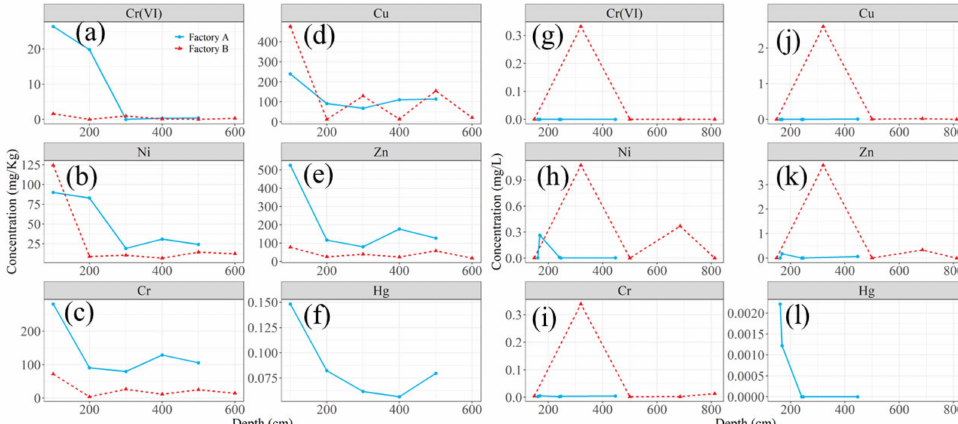
Figure 4. Concentrations of Cr (VI), Cu, Ni, Zn, Cr, Hg in the soil ( a – f ) and groundwater ( g – l ) in relation to the depth. The solid and the dashed lines denote the concentrations in Factory A and B, respectively. The highest concentration of the heavy metal is observed in the topsoil for both factories ( a – f ). Most of the maximum concentration is observed in shallower places for Factory A whereas the maximum concentration is observed at deeper places for Factory B in groundwater ( g – l